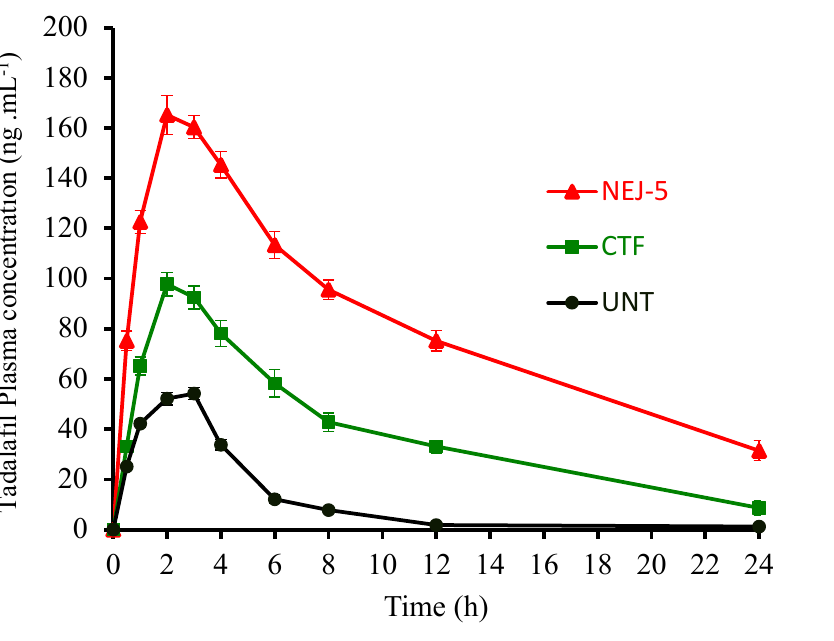
Figure 9. In vivo assessment of tadalafil formulations: nano-emulsified jelly (NEJ-5), commercial tablet formulation (CTF) and unprocessed tadalafil (UNT). Table 10. Pharmacokinetic parameters of tadalafil in rats after oral administration.